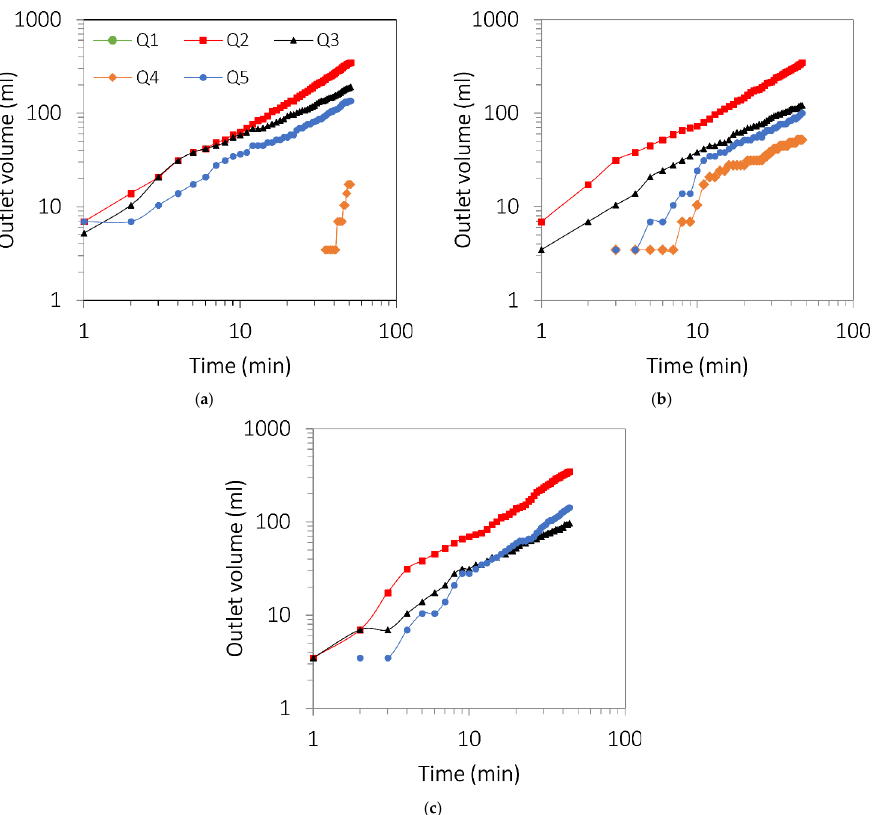
Figure 4. Outlet volume (mL) vs. time (min) at different test sections for Fracture ‐ 1, with an inclination of ( a ) 45°; ( b ) 55°; ( c ) 65°. The effect of fractal dimension on the outlet volume can be analyzed by comparing Fracture ‐ 1 (Figure 4a) and Fracture ‐ 2 (Figure 5a) with the same inclination angle ( β = 45°) and mismatch length ( λ = 30 mm). The increase in fractal dimension from 2.2 to 2.4 affects the outlet flow rate distribution. This is highlighted in Figure 5a, where section Q5 pre ‐ sents the maximum flow rate, while in this case section Q3 remains empty. A comparison between Figures 4a and 5a indicates that the increase in fractal dimension results in a 77% increase in mean flow rates of Q5.